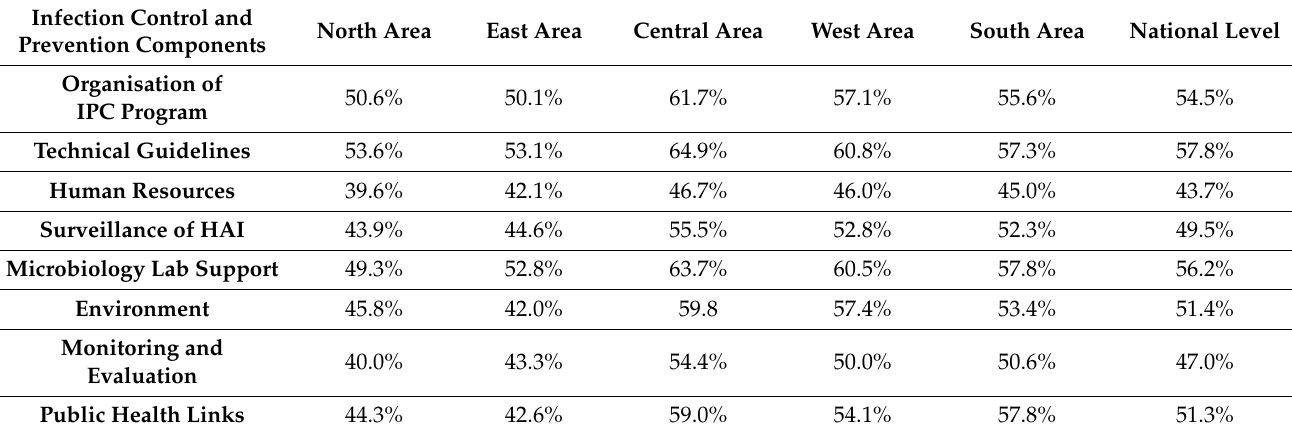
Table 2. Illustration of key IPC components and their values in different parts of the KSA